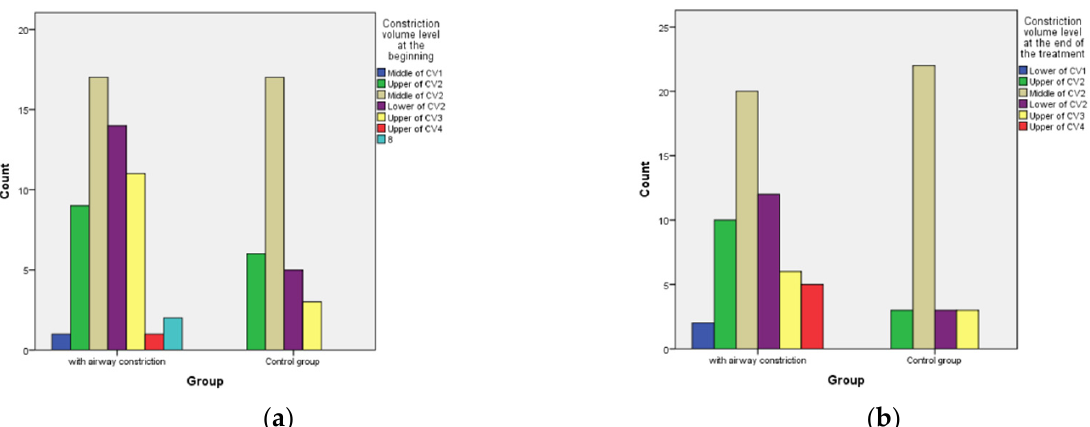
Figure 9. Level of airway constriction according to the level of the cervical vertebrae as shown at the cephalometric lateral x-ray exported from the CBCT. ( a ) Pre-treatment levels of constriction; ( b ) post-treatment levels of highest constriction (smallest clearance).